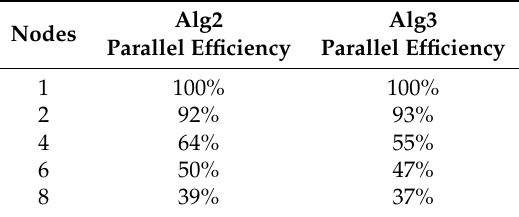
Figure 7. The speedup comparison between Alg2 and Alg3. Table 5. Parallel efficiency comparison between Alg2 and Alg3.